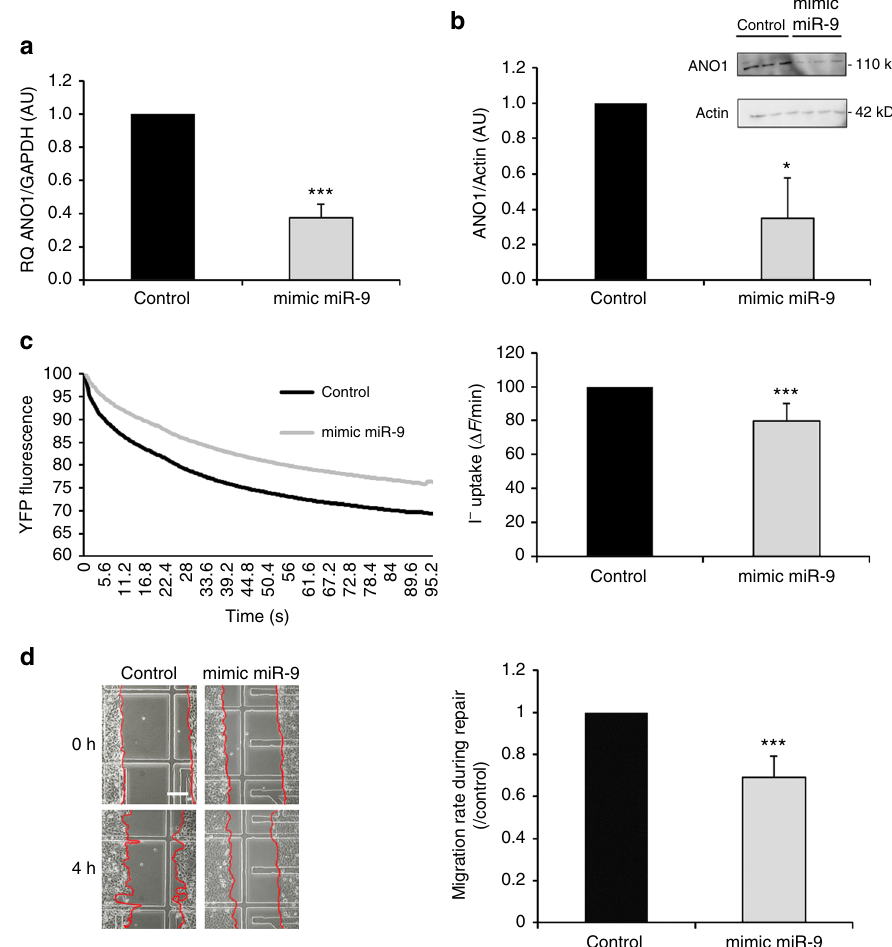
Fig. 2 miR-9 regulates ANO1 expression, ANO1 chloride activity, and non-CF cells migration. Non-CF cells (16HBE14o-) were transfected with a miR-9 mimic (30 nM) or a negative control for 48 h. a ANO1 mRNA expression was analyzed by RT-qPCR and normalized to GAPDH ( n = 3). Data are presented as the mean ± SD and were compared using Student ’ s t -test. All qRT-PCR experiments were performed in triplicate. b ANO1 protein expression was analyzed by western blotting using anti-ANO1 antibody and normalized to β -actin ( n = 3, in triplicates). Data are presented as the mean ± SD and were compared using Student ’ s t -test. c ANO1 chloride channel activity assessed by I − quenching of halide-sensitive YFP-H148q/I152L protein. Representative and original traces of ANO1 chloride activity ( left ) and quanti fi cation ( right ) of non-CF cells transfected with a miR-9 mimic or negative control ( n = 8, in triplicates). Data are presented as the mean ± SD and were compared using Student ’ s t -test. d Representative images were taken during 4 h of wound closure of non-CF cells transfected with a miR-9 mimic or a negative control ( left ) and quanti fi cation of the migration rates during repair ( n = 5). Data are presented as the mean ± SD and were compared using Student ’ s t